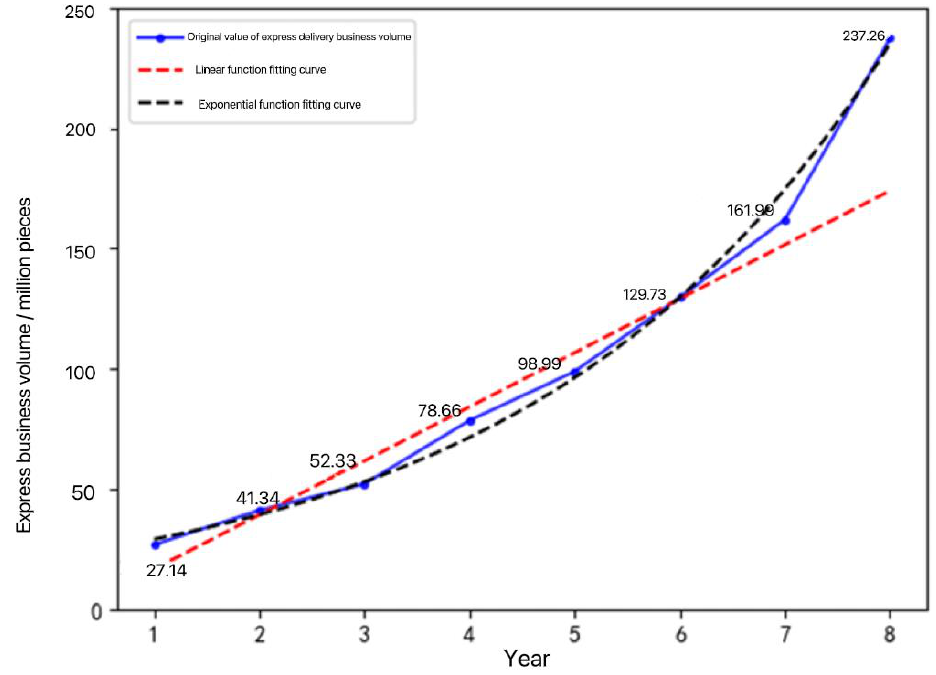
Figure 3. Fitting graph of express business volume .